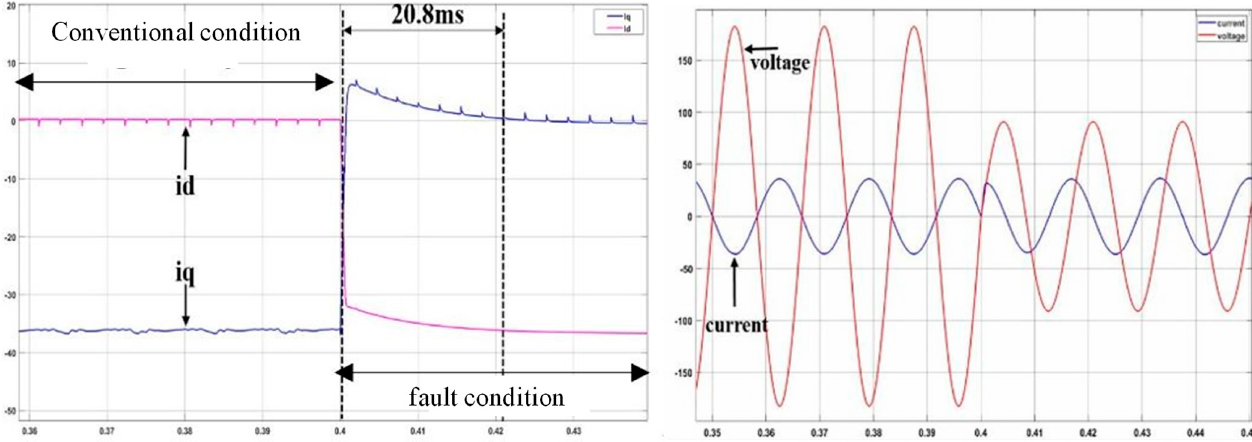
Figure 28. Phase voltage, current, and reactive current response results for independent operation depending on grid voltages.